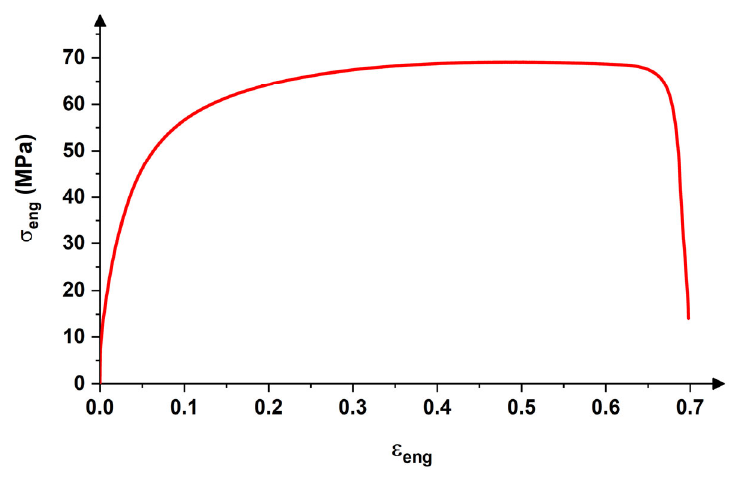
Figure 4. Engineering strain–stress curve measured by tensile test for 1050 Al alloy.